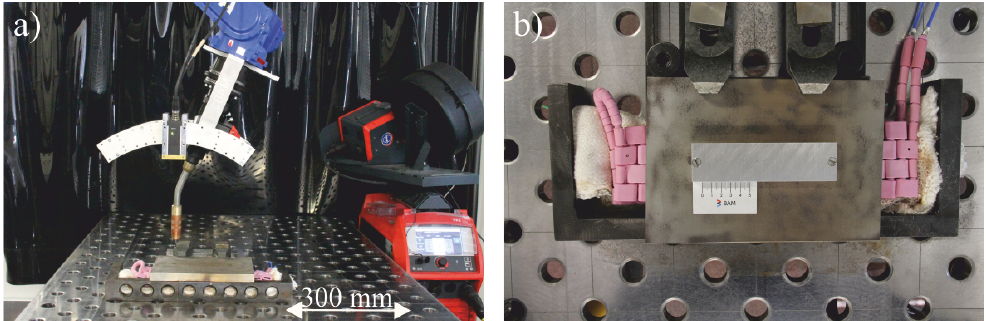
Figure 1. ( a ) Welding equipment, ( b ) heating and substrate